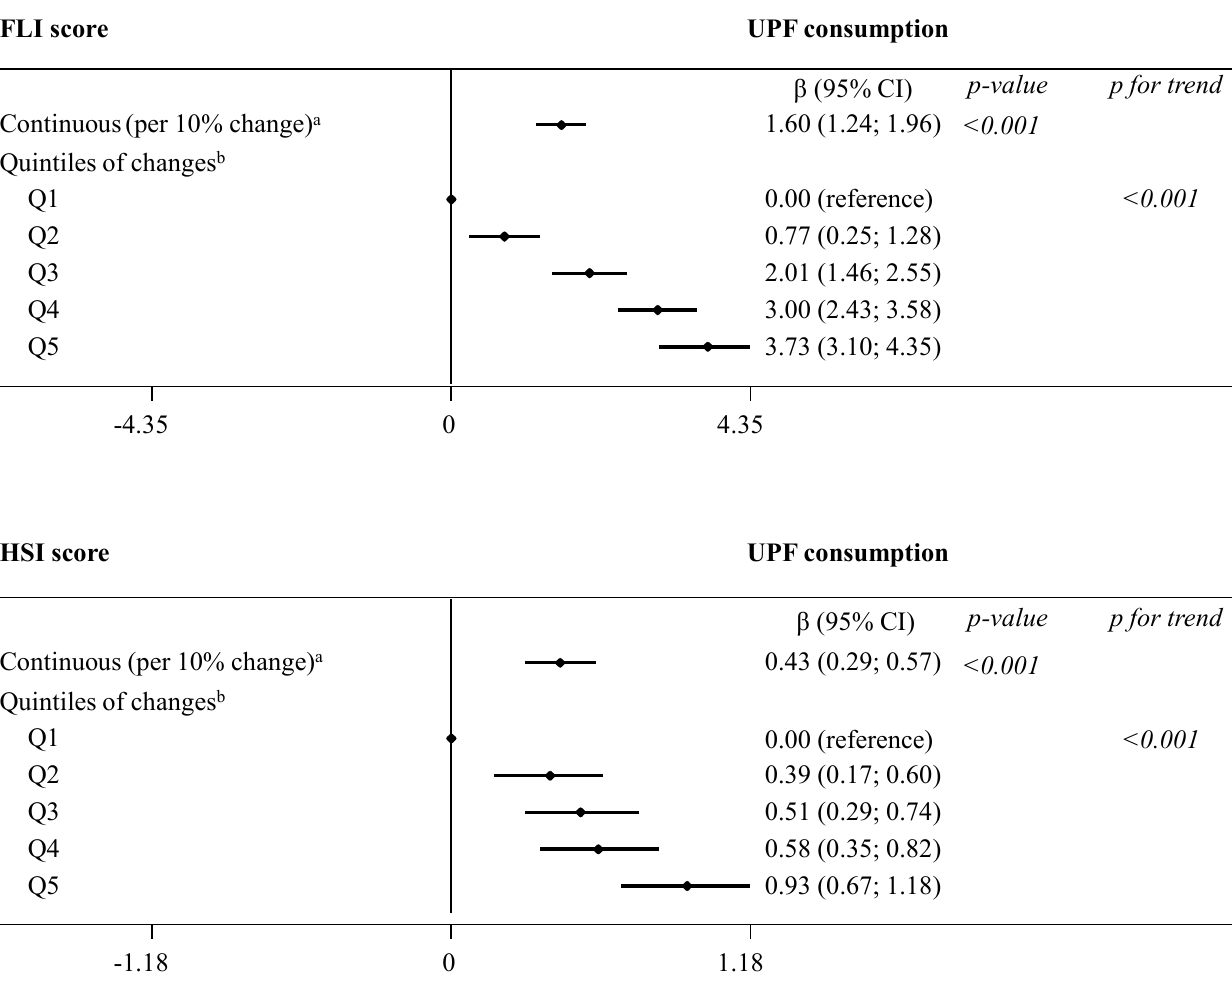
Figure 1. Dose–response relationship in the association between concurrent changes in UPF con- sumption (% of g/day) and changes in NAFLD indices during 1 year of follow-up (fully adjusted model 2). The consumption of UPF was expressed as a percentage of total food and beverage intake in g/day. Daily intake of beverages was collected in cubic centimeters and then converted into mil- liliters (1 cc = 1 mL), and further into grams, assuming that 1 mL = 1 g. Mixed-effects linear modelling for repeated measures with random intercepts at recruiting center, cluster family, and patient level were used after controlling in fully adjusted model 2 for baseline variables, such as age, sex, study arm, educational level, smoking habits, and height, as well as repeatedly measured physical activity, sedentary behavior, alcohol intake, and follow-up time. a Estimates β are interpreted as changes in NAFLD associated with increments of 10% in UPF consumption. b Estimates β are interpreted as changes in NAFLD indices in each sex-specific quintile of UPF consumption, compared to quintile